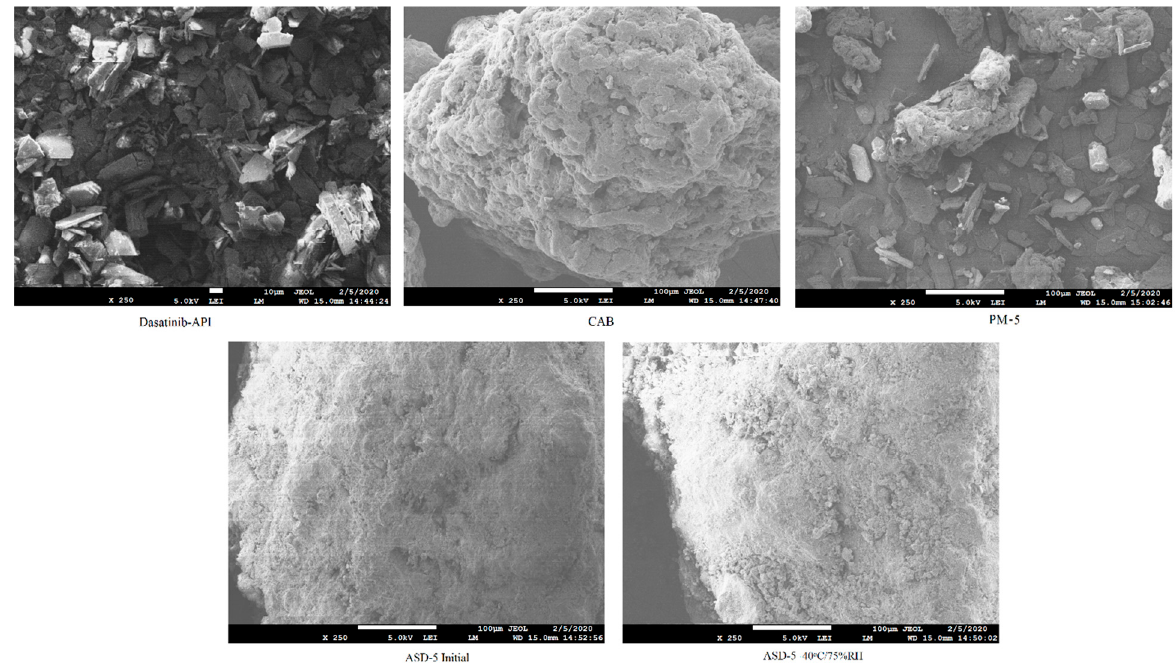
Figure 1. Scanning electron microscopic images of DST, CAB, PM − 5, ASD − 5 initial and 40 °C/75% RH exposed.